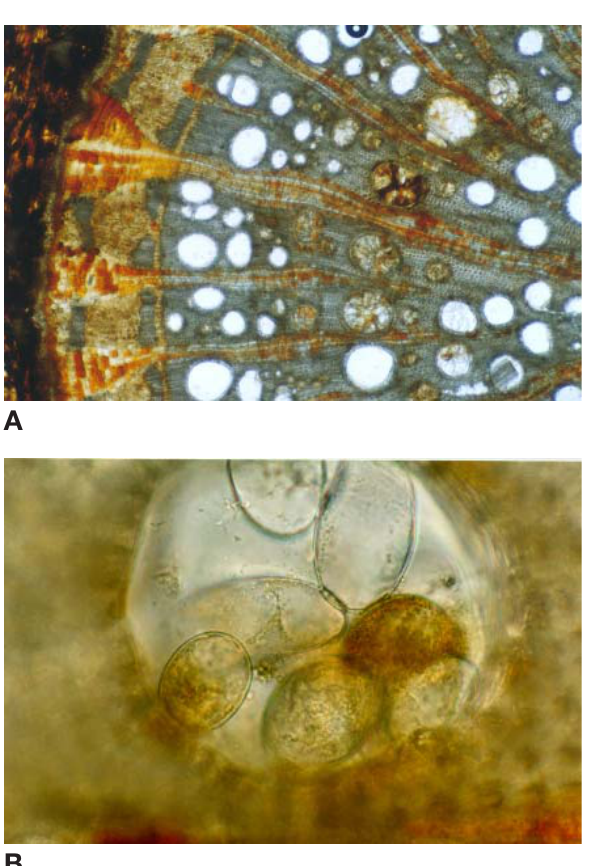
Fig. 1. A. Cross-section of infected SO4 vine roots ( (cid:1) 100). B. Xylem with tyloses ( (cid:1)